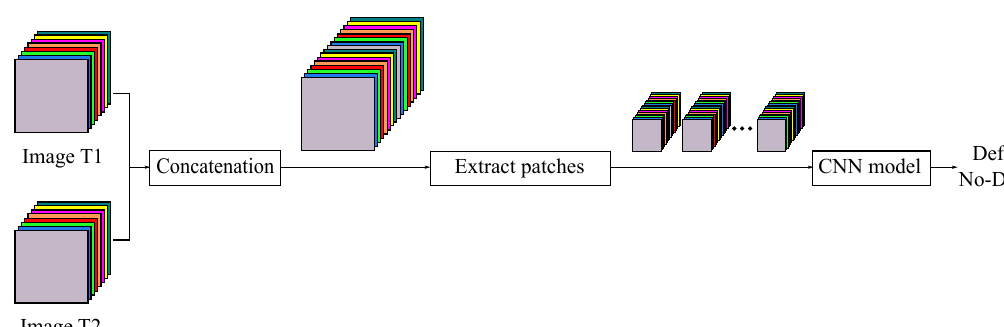
Figure 1. EF method. Co-registered images acquired at T1 and T2 are stacked along the spectral dimension; correspondent patches of both images are the input for the CNN model.